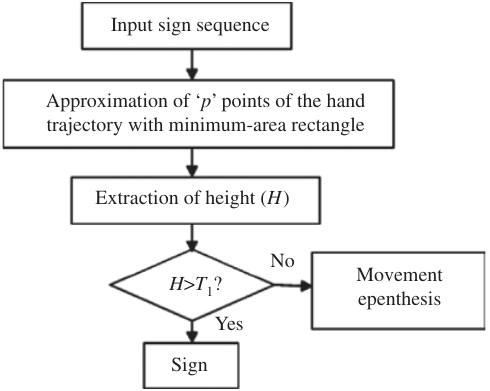
Figure 4: Proposed ME Detection Module for a Continuous Sign Sequence.